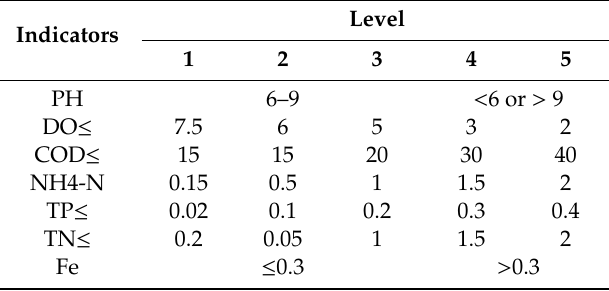
Table A1. Water quality standard of surface water in China (GB3838–2002) mg /